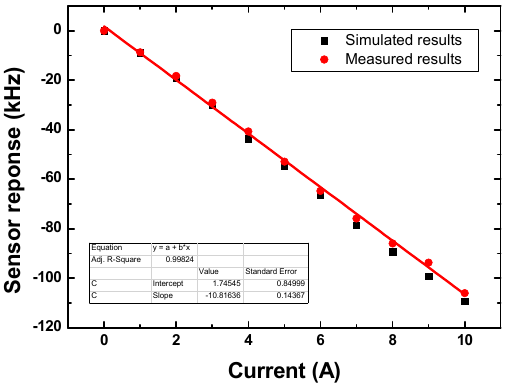
Figure 16. The sensitivity evaluation of the developed FeNi coated sensor.